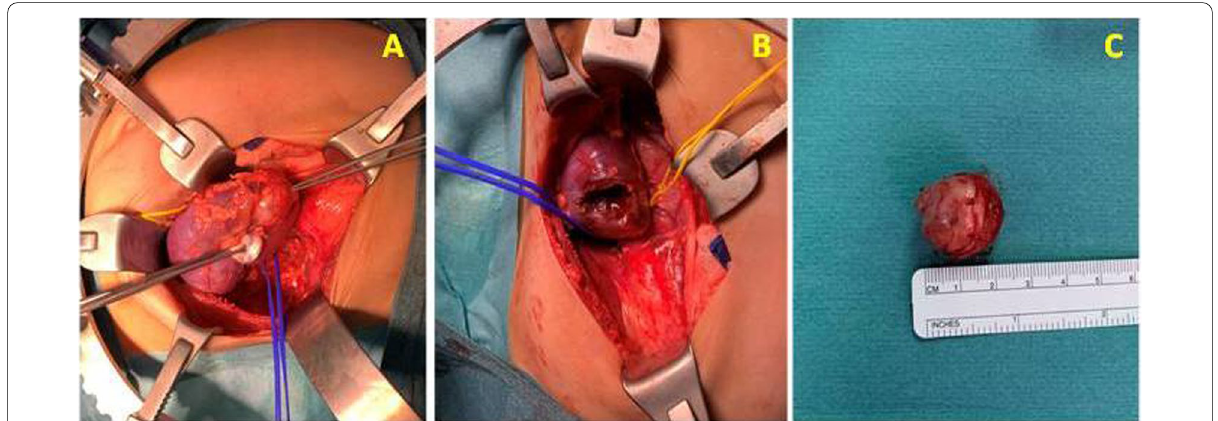
Fig. 2 Intra-operative photos. A Showing the mass at the upper pole of the left kidney. B Showing the left kidney after excision of the mass. C Showing the mass after excision